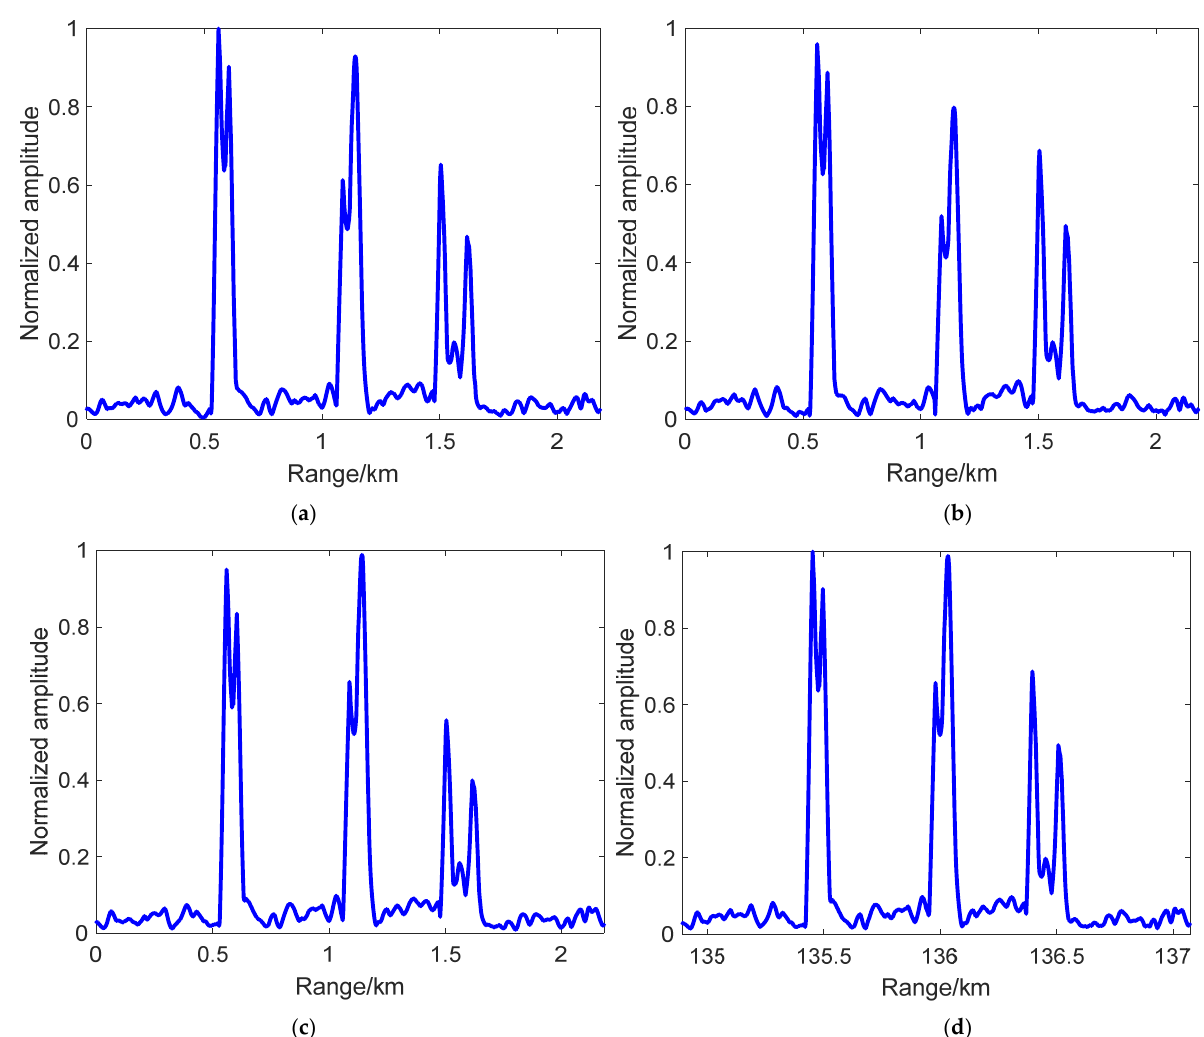
Figure 12. Doppler compensation comparison of method 2 in a one-dimensional range image by B3I signals of satellite 3: ( a ) results with first target Doppler compensation; ( b ) results with second target Doppler compensation; ( c ) results with third target Doppler compensation; ( d ) results with the proposed MTDC method based on multiple estimated target Dopplers.